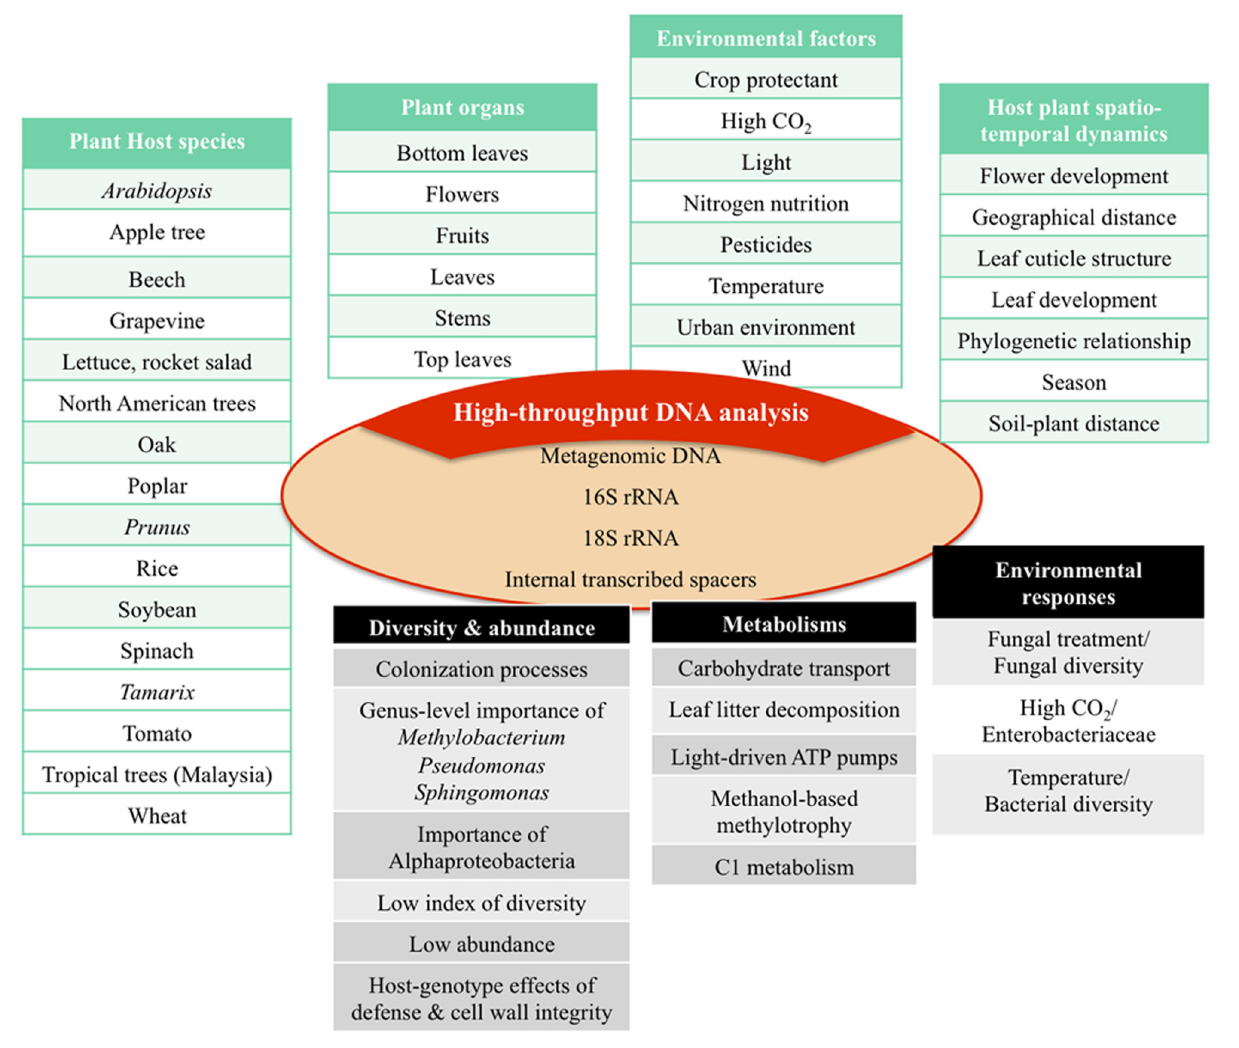
presented in Supplementary Table S1 represent a selection of studies that were performed in the last years using NGS technologies. Further studies can be found in tables of other recent reviews (Rastogi et al., 2013; Knief, 2014; Müller and Ruppel, 2014). Taken together, these studies give a dynamic view of phyllosphere microbiota biodiversity, metabolisms, and environmental plasticity.